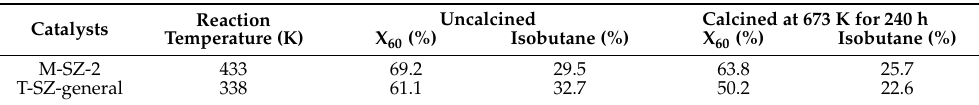
Table 5. Comparison of the butane isomerization catalyzed by M-SZ-2 and T-SZ-general before and after calcination at 673 K for 240 h at different reaction temperatures for 60 min.